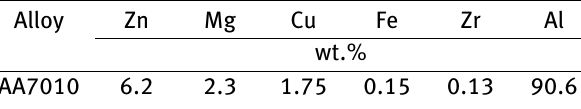
Table 1: The chemical composition of